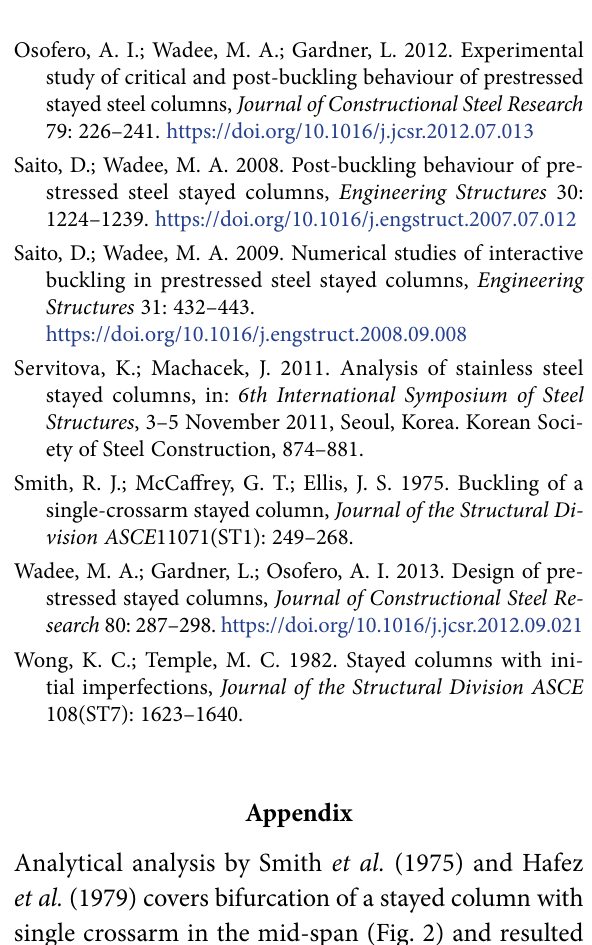
Fig. A1. Initial stay prestress (per stay) versus buckling load of the